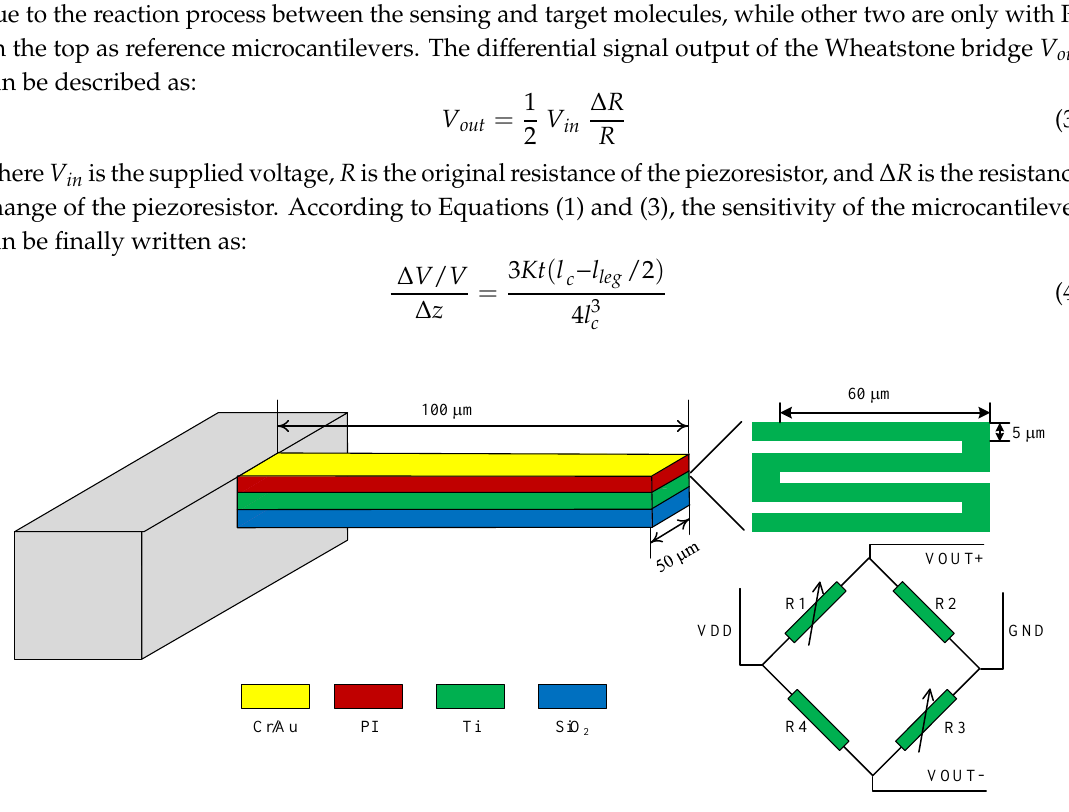
Figure 1. The schematic diagram of the polyimide (PI)/titanium (Ti)/silicon oxide (SiO 2 ) microcantilever. The shape of the piezoresistor is four-fold and four microcantilevers consist of a Wheatstone bridge.